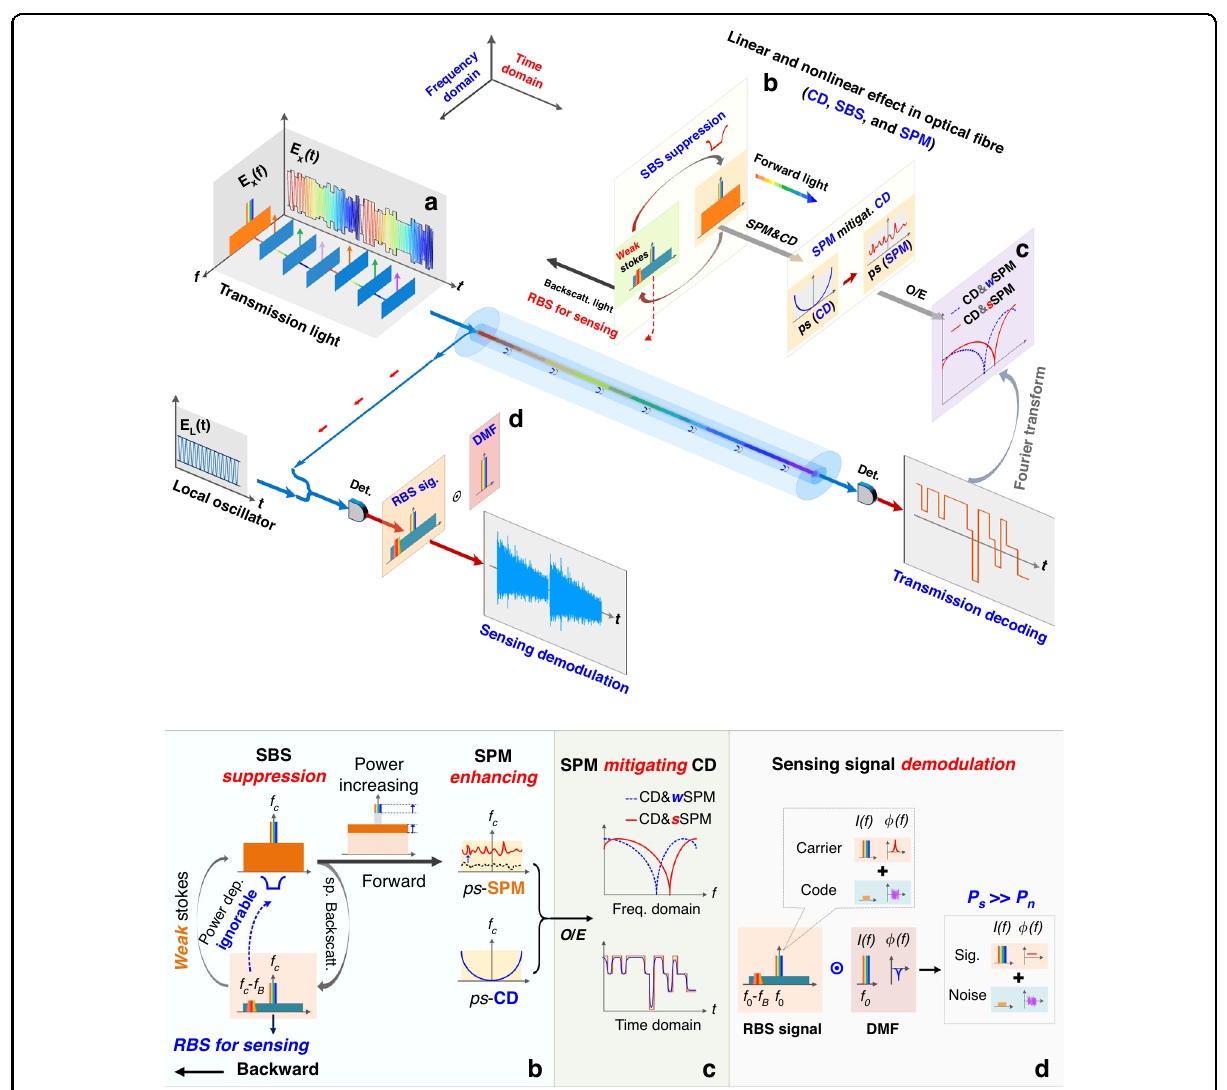
Fig. 1 Illustration of the integrated sensing and communication in an optical fi bre (ISAC-OF). SBS stimulated Brillouin scattering, SPM self- phase modulation, CD chromatic dispersion, RBS Rayleigh backscattering, w SPM weak SPM, sS PM strong SPM, Det. detector, DMF digital matched fi lter, power dep. power depletion, sp. Backscatt. spontaneous backscattering, ps phase spectrum. a Time and frequency characteristics of the transmission light. b The linear and non-linear effects in optical fi bre, including light backscattering, CD, SBS, and SPM. c The characteristics of the electrical signal for CD mitigation using SPM. The blue dashed line represents the result of the interaction between weak SPM and CD. The red line represents the result of the interaction between strong SPM and CD. d The illustration of the sensing signal demodulation in the frequency